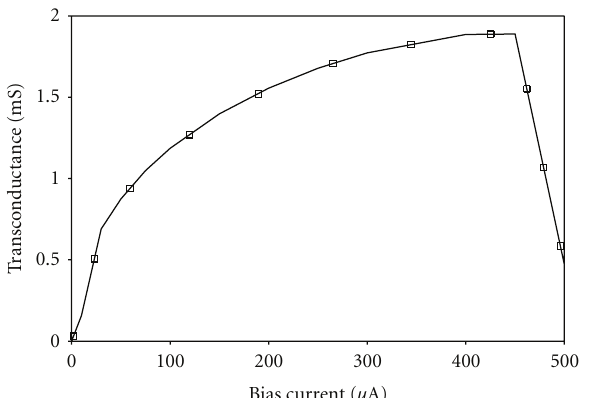
Figure 5: Variation of transconductance with bias current.